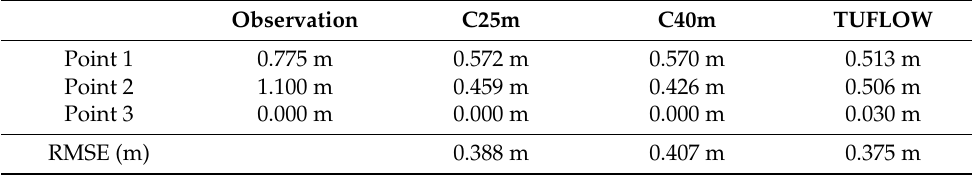
Figure 17. Maximum flood extent of the ( a ) Chiayi County DEM and observation points (red dots), ( b ) C25 m and ( c ) C40 m. Table 2. Comparison of observed and simulated maximum flood depths at different